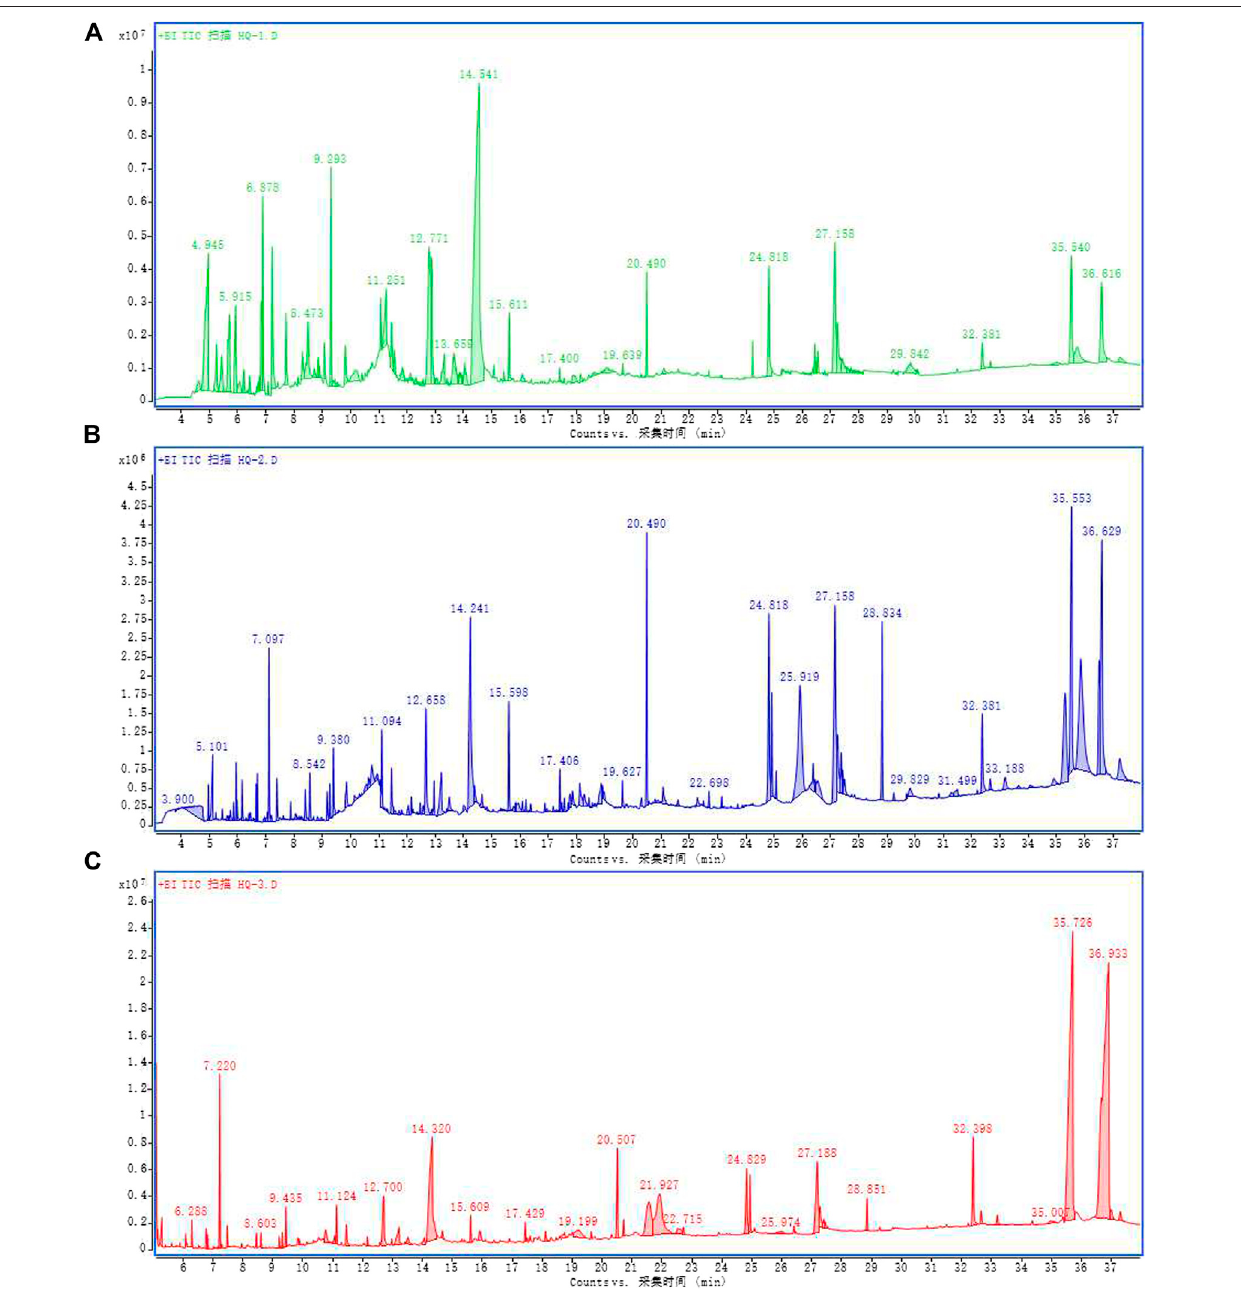
FIGURE 1 | Ion fl ow diagram of the three gas chromatography-mass spectrometry extraction methods for S. baicalensis Georgi by (A) ethanol (B) methanol, and (C) benzyl alcohol.